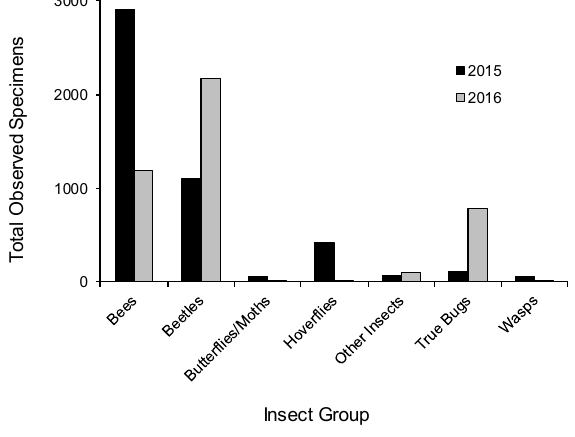
Figure 1. Total observed specimens of each insect group per year.